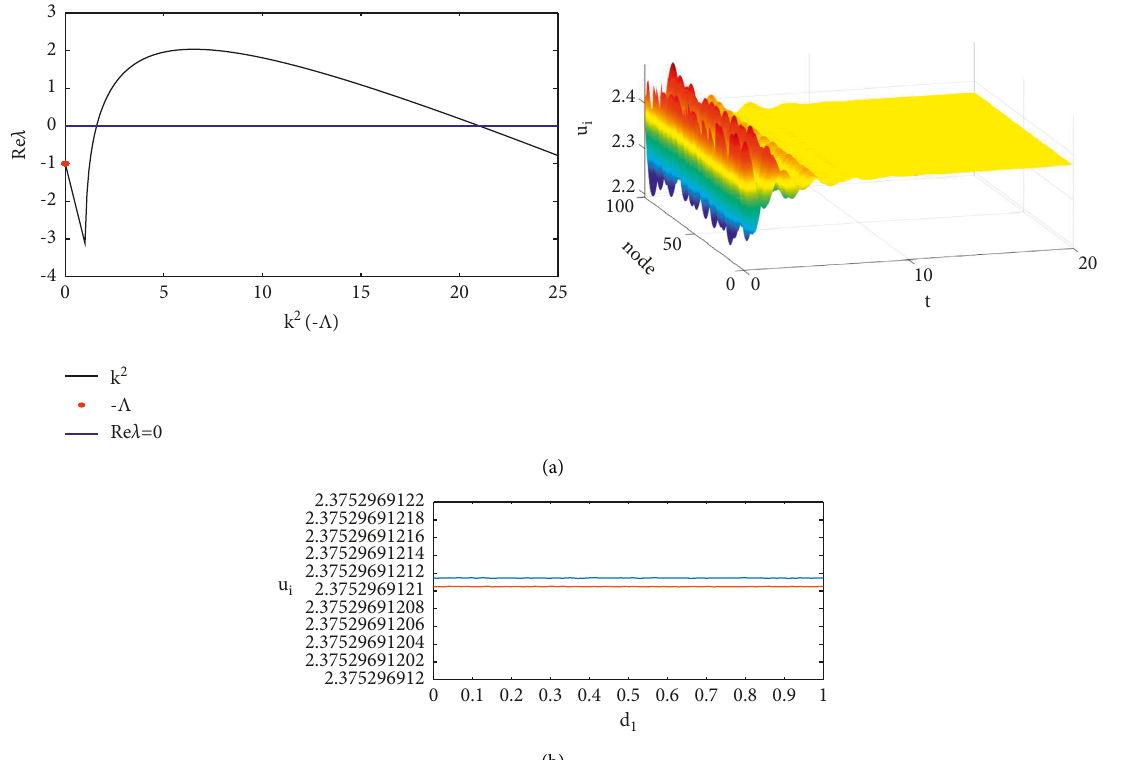
Figure 6: (a) Instability region (left) of random network and pattern formation (right) in random network when p � 0 . 00006 , d (b) The bifurcation about d when p � 0 . 1